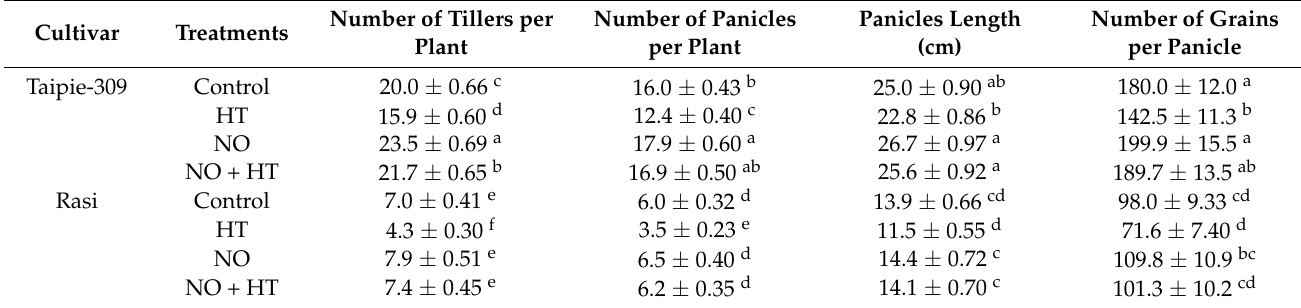
Table 4. Number of tillers per plant, number of panicles per plant, panicles length, and number of grains per panicle in Taipie-309 and Rasi cultivars of rice ( Oryza sativa L.) at harvest time, plants were grown with/without high temperature (HT) stress and treated with foliar 100 µ M SNP (NO